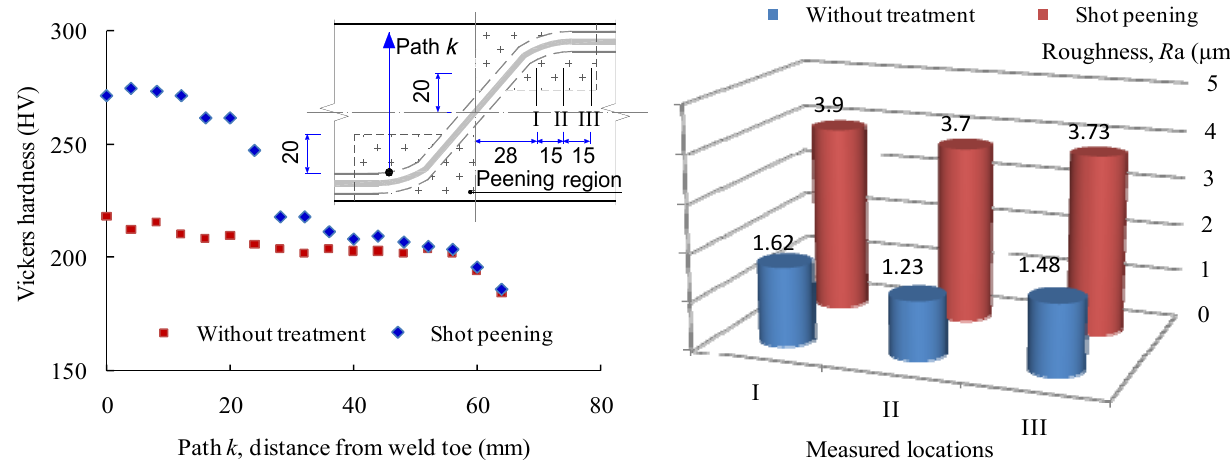
Figure 3. Hardness and roughness comparison of specimens with shot peening and without treatment.